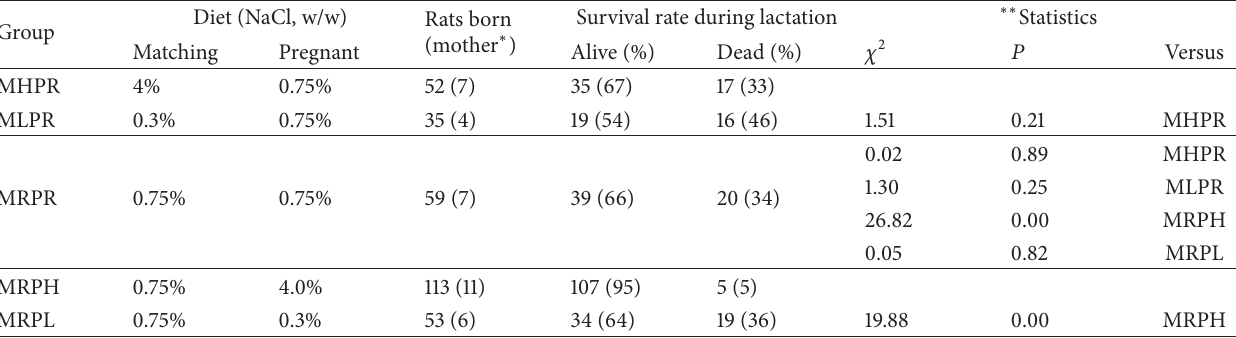
Table 2: Mortality rates of the newborn pups until